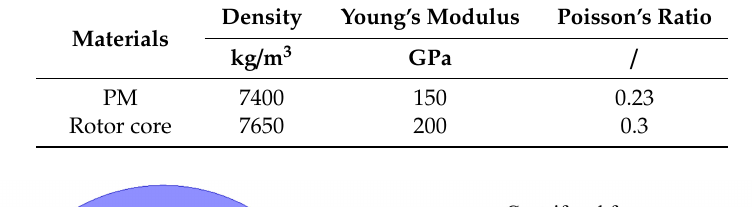
Table 2. Material properties of the permanent magnet (PM) and rotor core.